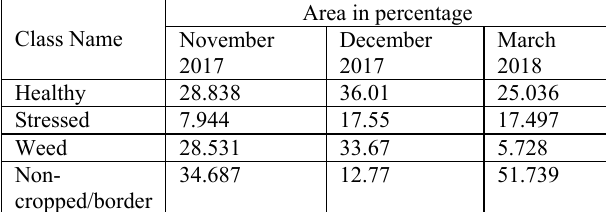
Table 3. The percentage wise calculation of area for under different classes.